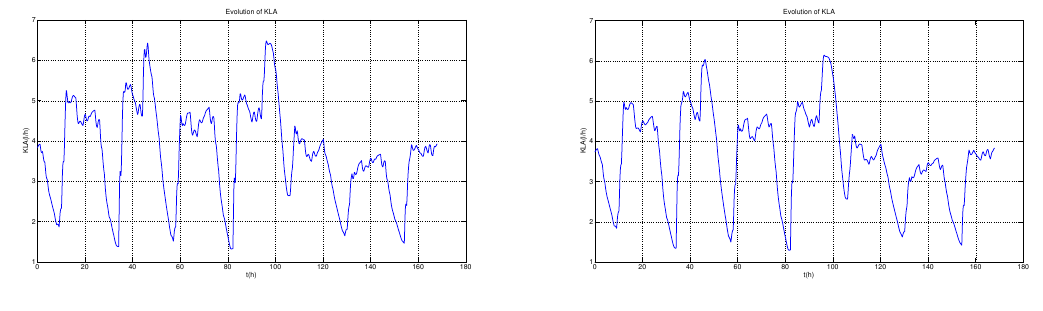
Figure 12. Profile of K La : (left) case3; (right) case 4.